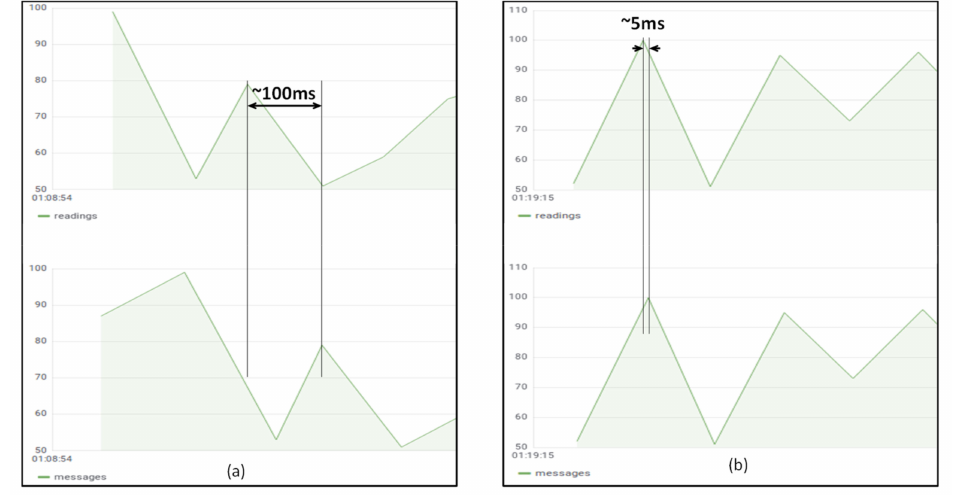
Figure 8. Latency measured between the IoT gateway and the IoT server when the gateway is executed in the Raspberry Pi Kubernetes cluster ( a ) and when the gateway is executed in the Google Kubernetes Engine cluster ( b